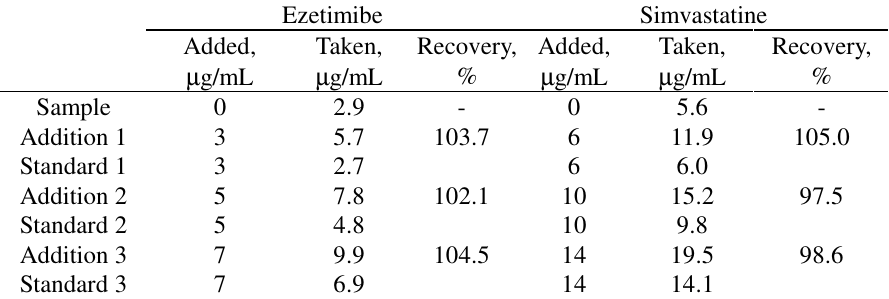
Table 4. Relative recovery of ezetimibe and simvastatin obtained by the first order derivative